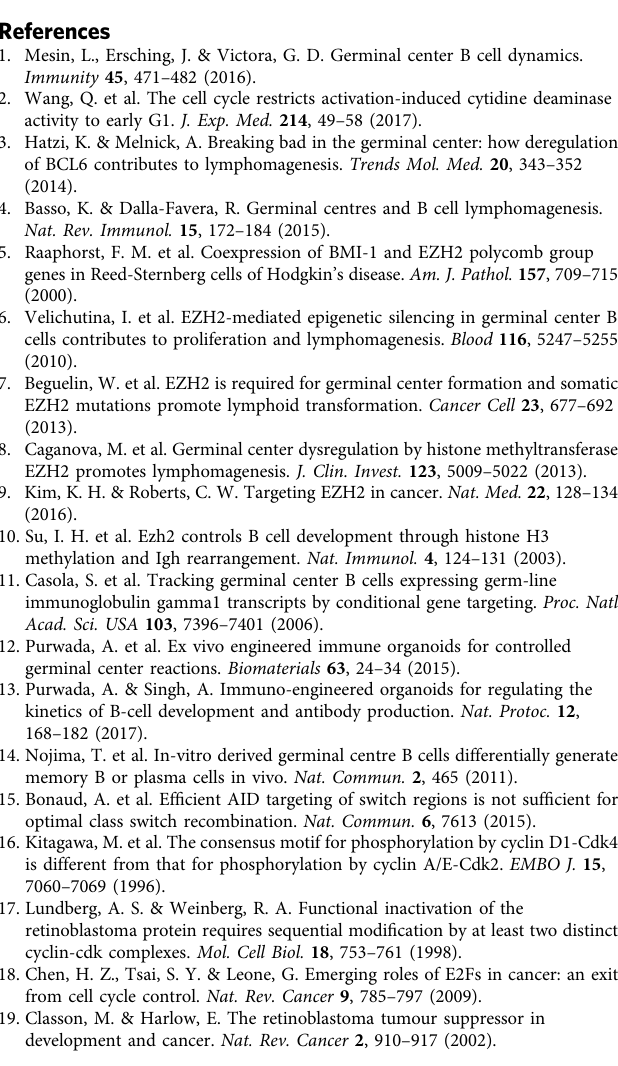
GSEA algorithm, a computational method based on the Kolmogorov – Smirnov